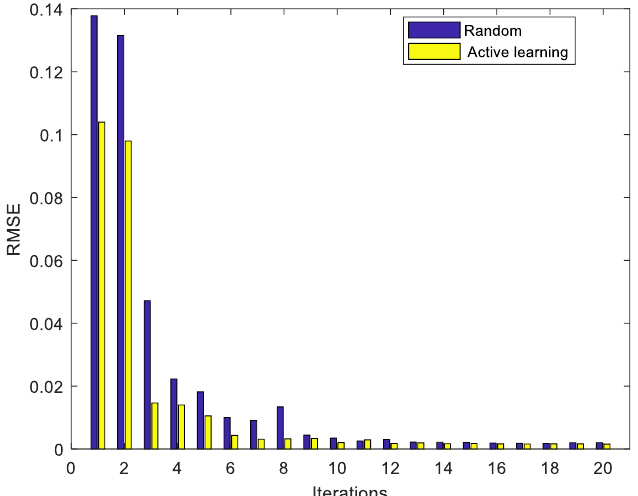
Figure 6. Prediction performance of soft sensors with AL strategy under different pruning results during iteration.